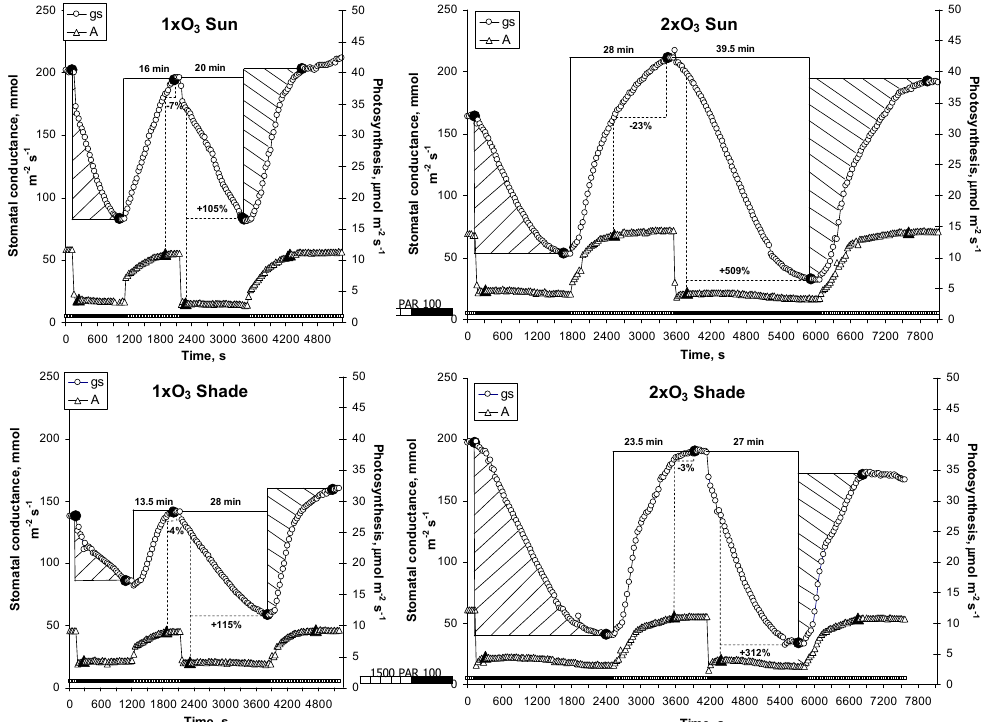
Figure 6. Example of fleck light responses in sun and shade leaves of beech trees. When stomatal conductance (gs) achieved equilibrium, the light intensity was sharply decreased from 1500 to 100 µmol m − 2 s − 1 until equilibrium, and then increased again. The treatment was repeated two times. Full symbols show the time equilibrium was reached, i.e., gs or A (photosynthesis) values were stable in the following two minutes. Full lines show examples of calculation of the time to open and to close stomata (in min). Dotted lines show examples of calculation of the error in recording gs at the time A reached equilibrium (as percent of steady-state gs). Slashed surfaces show examples of cumulated water loss and stomatal O 3 uptake when stomata closed (/) and opened (\).